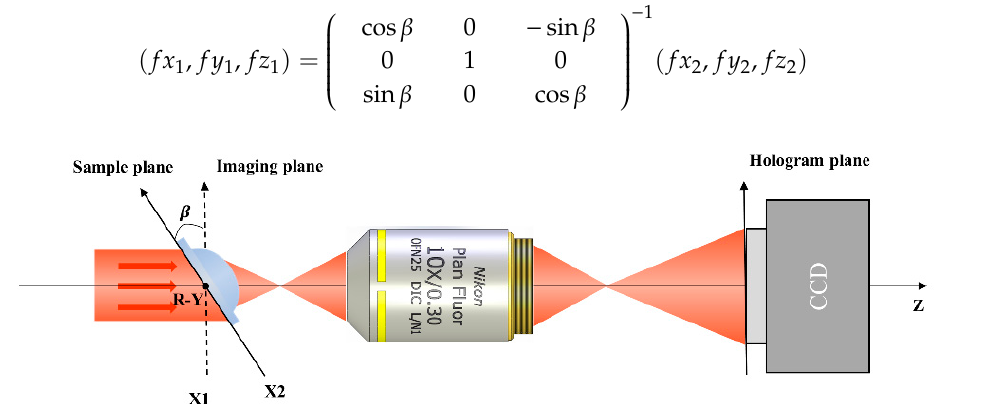
Figure 4. Schematic of the algorithm for diffraction calculation.